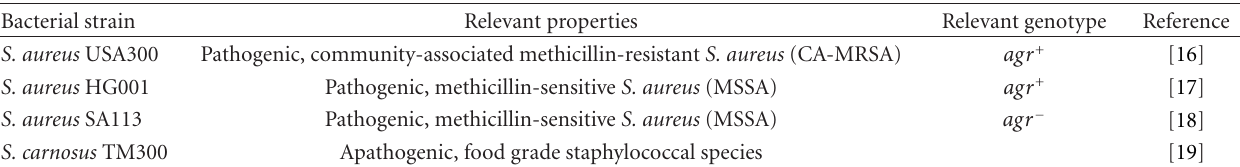
Table 1: Bacterial strains used in this